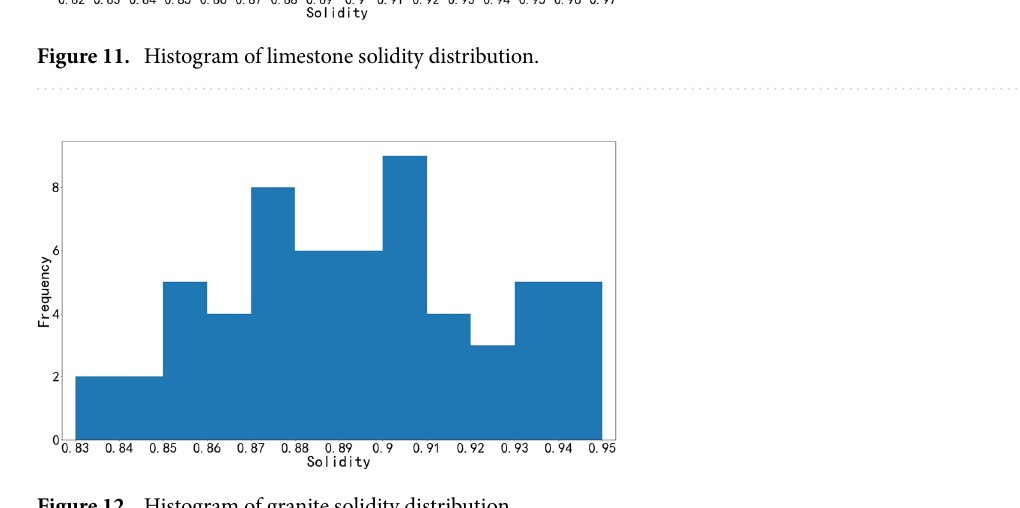
Figure 12. Histogram of granite solidity